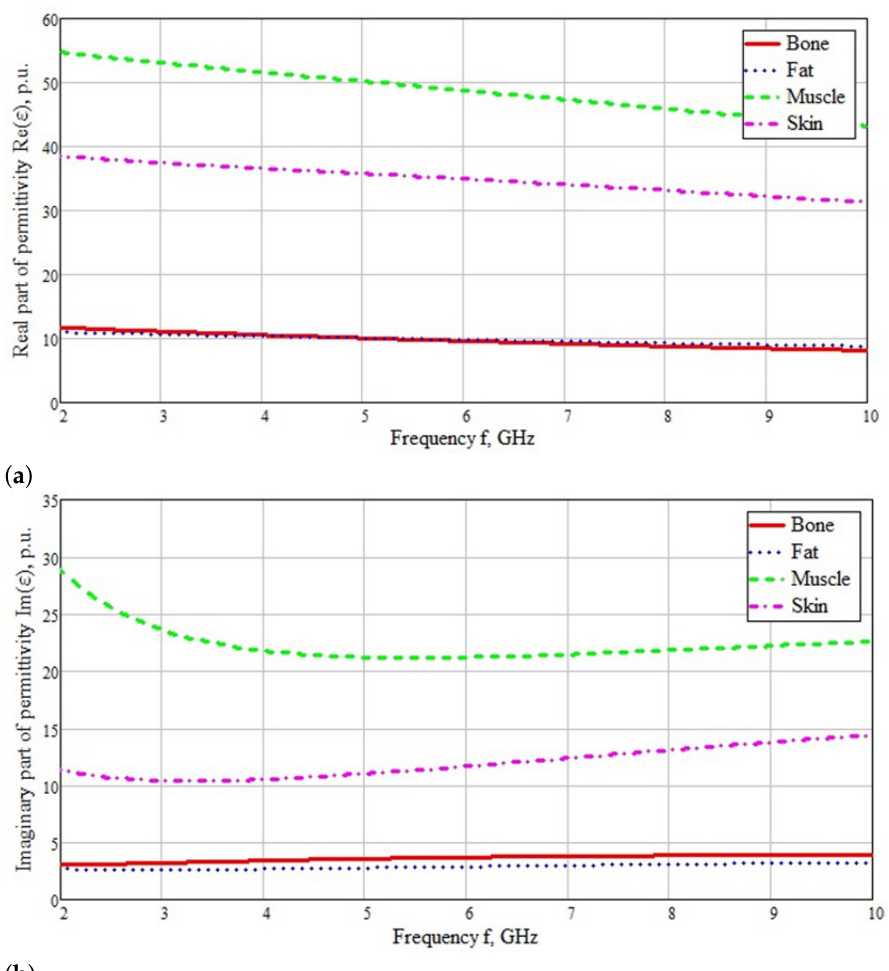
Figure 3. Frequency dependence of the real ( a ) and imaginary ( b ) parts of the relative permittivity on the